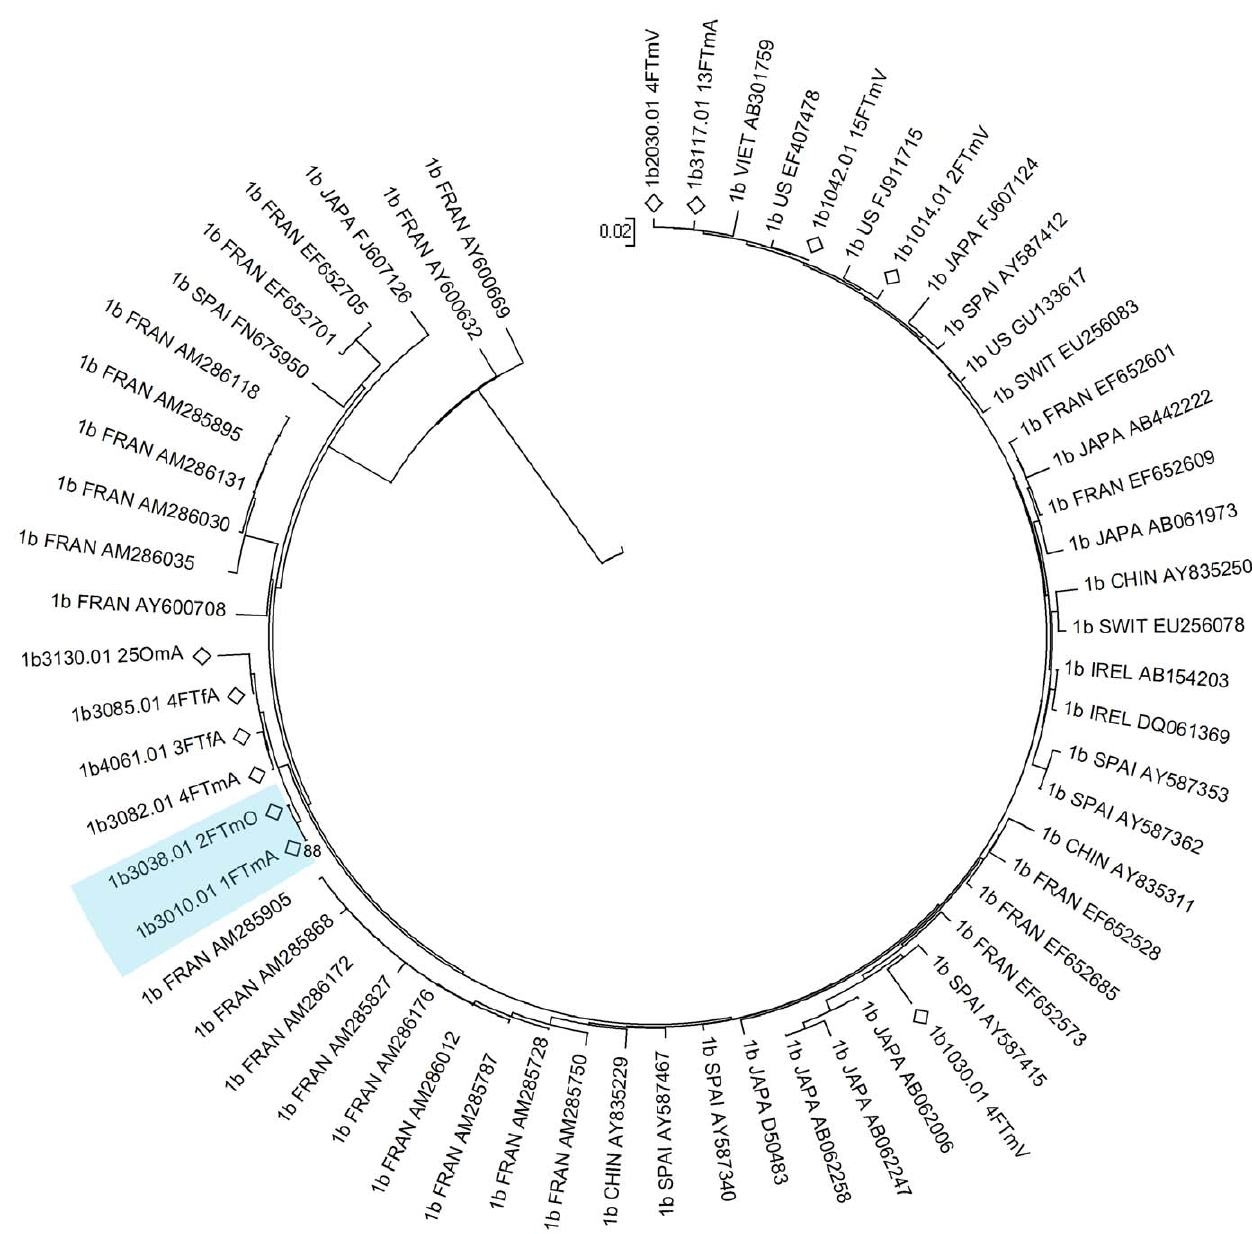
Figure 4. Neighbour-joining analysis of HCV genotype 1b core sequences. Comparison sequences were genotype 1b sequences randomly selected from the LANL HCV database. Study participants are denoted by diamonds. The first four letters of the name of the country of origin of LANL sequences is included in the ID. Phylogenetic clusters defined by bootstrap analysis (cut-off 70%) with infections from multiple individuals in the study are highlighted in blue and bootstrap values for these clusters are